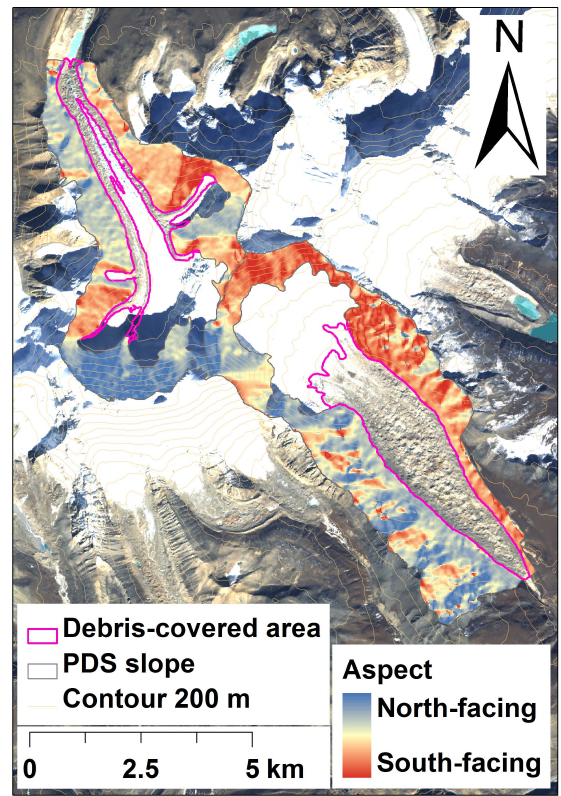
Fig. 7. Aspect distribution of potential debris-supply (PDS) slopes of north-flowing and south-flowing debris-covered glaciers in the Kulha Kangri Massif region. Background image is AVNIR-2. The location of this area is indicated in Fig.